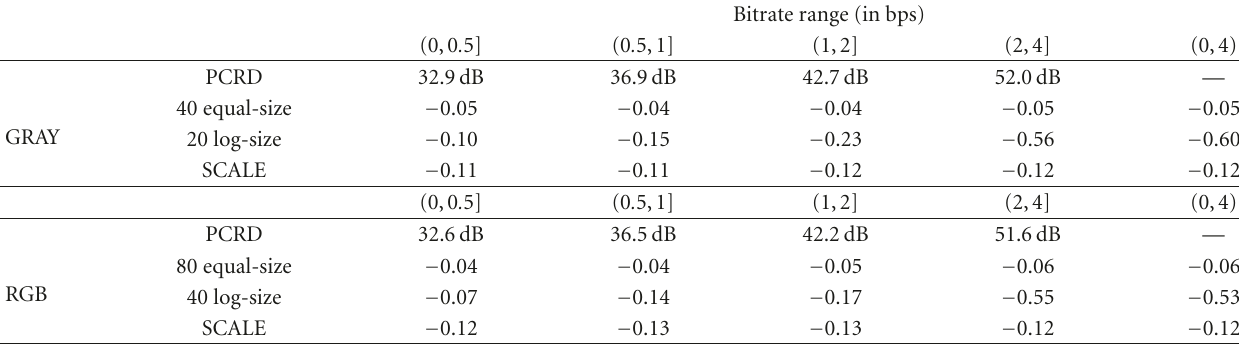
Table 1: Average coding performance achieved with SCALE and the two common strategies of quality layers allocation. Average results, in di ff erent bitrate ranges, for all images of the corpus ISO/IEC 12640-1.